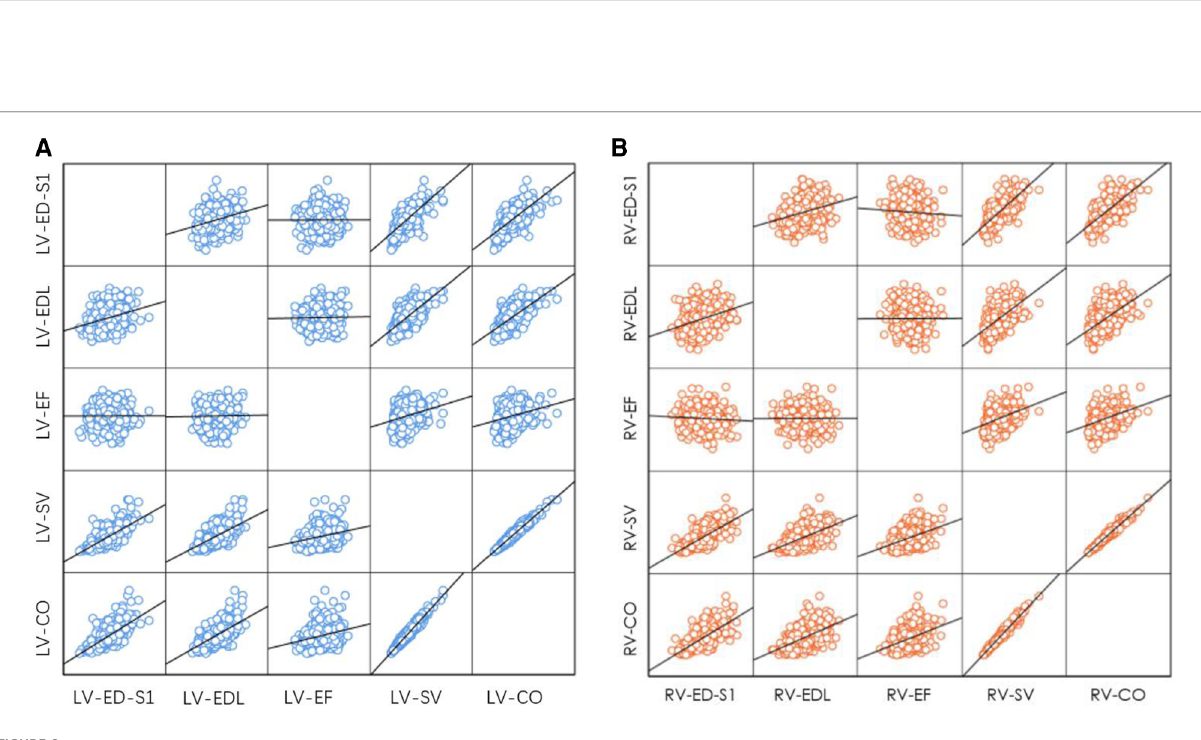
FIGURE 8 Correlation between end-diastolic ventricular size (ED-S1, EDL) and ventricular systolic function parameters (EF, SV, CO). ( A ) Left ventricle; ( B ) right ventricle. LV, left ventricle; RV, right ventricle; ED-S1, end-diastolic diameter segment 1; EDL, end-diastolic length; EF, ejection fraction; SV, stroke volume; CO, cardiac